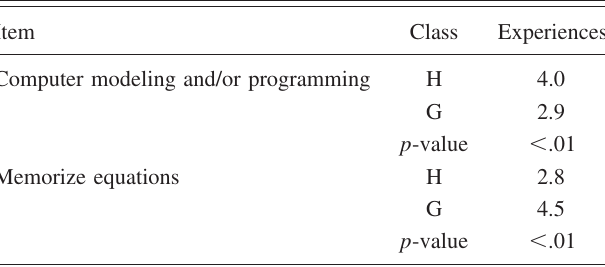
TABLE VIII. Differences in experiences at